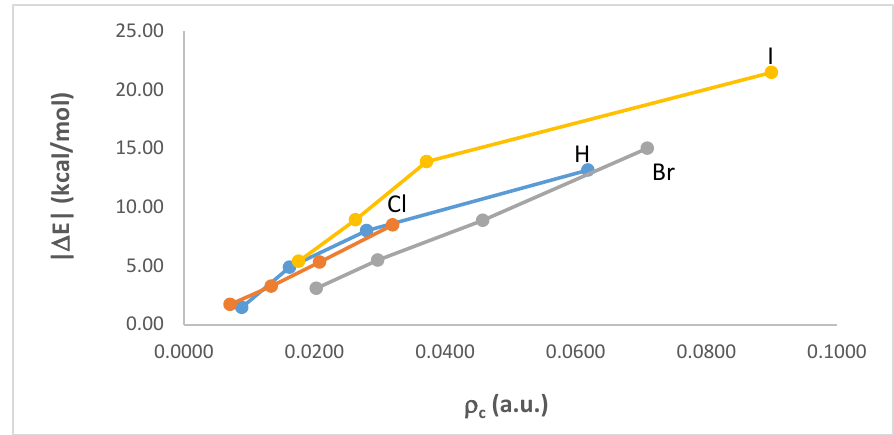
Figure 7 . Correlations between  c and the corresponding magnitude of interaction energies, |  E|, Figure 7. Correlations between ρ c and the corresponding magnitude of interaction energies, | ∆ E|, in the CH 3-n (CN) n X∙∙∙NMe 3 (X = H, Cl, Br, or I; n = 0–3) dimer complexes. in the CH 3 − n (CN) n X ··· NMe 3 (X = H, Cl, Br, or I; n = 0–3) dimer